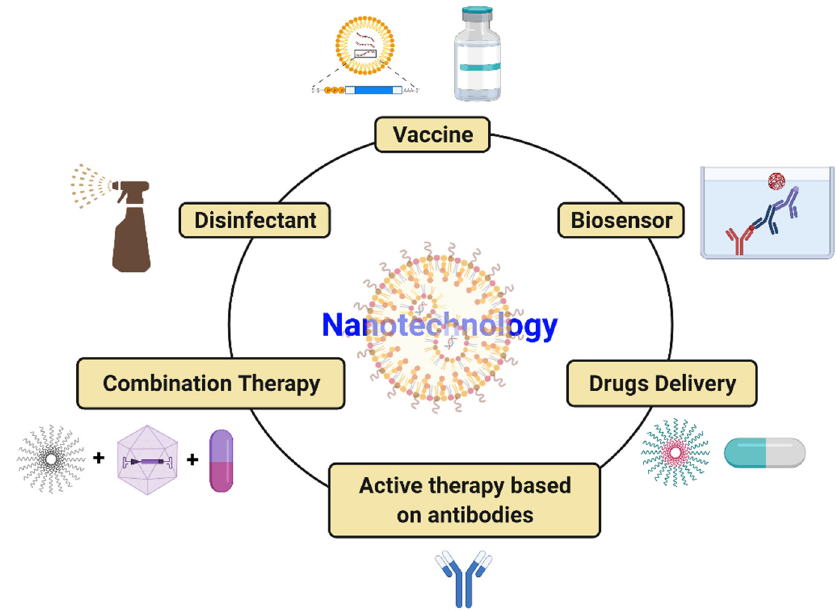
Figure 5. Potential strategies to tackle SARS-CoV-2 utilizing nanotechnology.